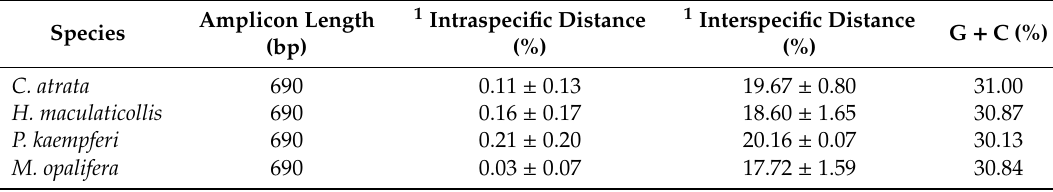
Figure 7. Phylogenetic tree using 48 samples of four species generated by the neighbor-joining method with 1000 bootstrap replicates based on CO1 sequences. Scale bar represents 0.2 substitutions per site. Table 3. Statistical characteristics of CO1